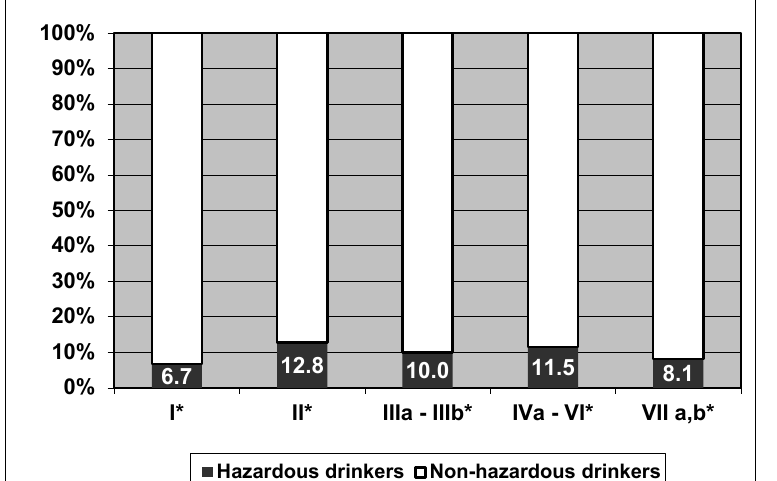
Figure 1. Proportion of hazardous drinkers by social class. I*: Higher-grade professionals, administrators and officials; managers in large industrial establishments; large proprietors. II*: Lower-grade professionals, administrators and officials; higher-grade technicians; managers in small industrial establishments; supervisors of non-manual employees. IIIa*: Routine non-manual employees, higher grade (administration and commerce). IIIb*: Routine non-manual employees, lower grade (sales and services). IVa: Small proprietors, artisans, etc. with employees. IVb: Small proprietors, artisans, etc. without employees. IVc: Farmers and smallholders; other self-employed workers in primary production. V: Lower-grade technicians; supervisors of manual workers. VI*: Skilled manual workers. VIIa*: Semi-skilled and unskilled manual workers (not in agriculture, etc.). VIIb*: Agricultural and other workers in primary production.